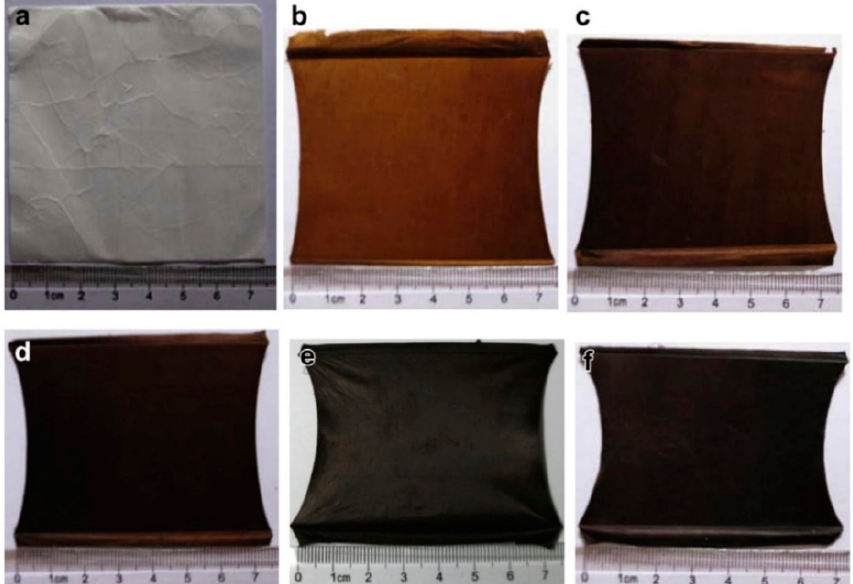
Figure 5. Pictures showing the color change of electrospun PAN mats during stabilization: ( a ) pristine and ( b – f ) stabilized (heating rate of 2 °C min − 1 in a constant air flow, and then maintained at the target temperature): ( b ) 250 °C for 1 h, ( c ) 265 °C for 1 h, ( d ) 280 °C for 1 h; ( e ) 280 °C for 2 h, and ( f ) 280 °C for 3 h. Reprinted and adapted with permission from ref. [52]; Copyrights 2012, Elsevier Ltd.